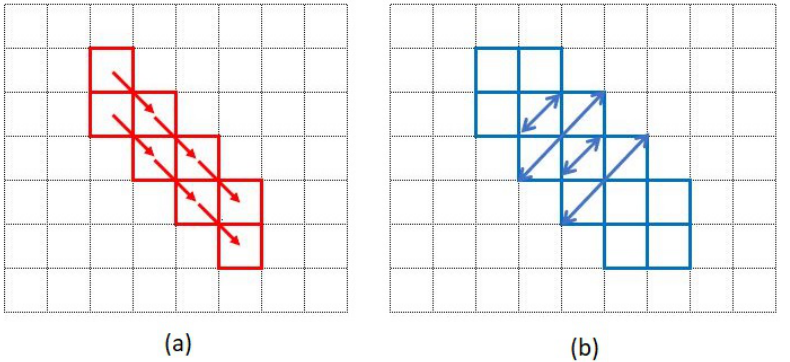
Figure 6. The behaviours of the two existing methods for wide LCPs for a sample diagonal move in a two-cell-wide path. Subfigure ( a ) is a sample diagonal move when the width is constant in terms of number of cells while subfigure ( b ) is trying to fix the width in terms of euclidean distance.